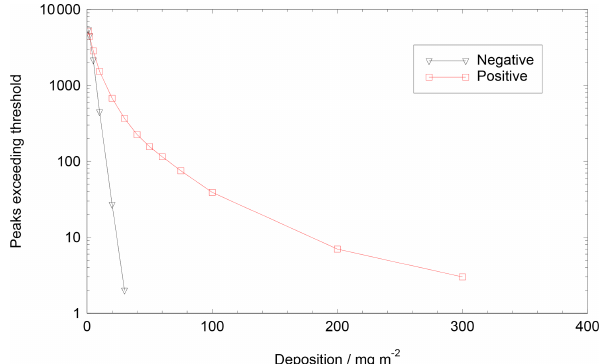
Figure 4. Distribution of positive and negative peaks exceeding dif- ferent deposition fluxes, summed over the past